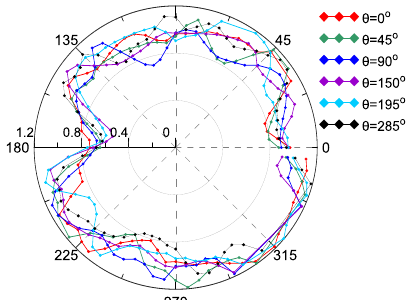
Fig. 5. Spray angular profiles with spurious distortions for different nozzle rotation